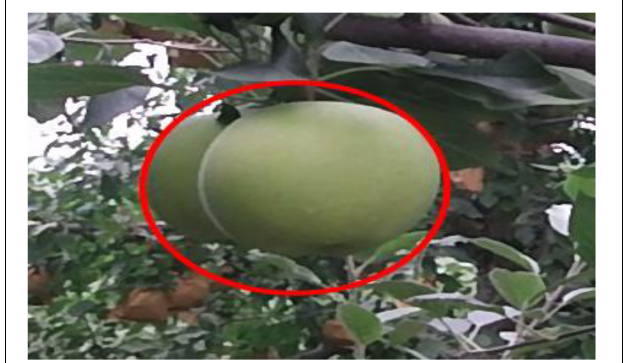
FIGURE 16 | The visualization results of an excessively overlapping